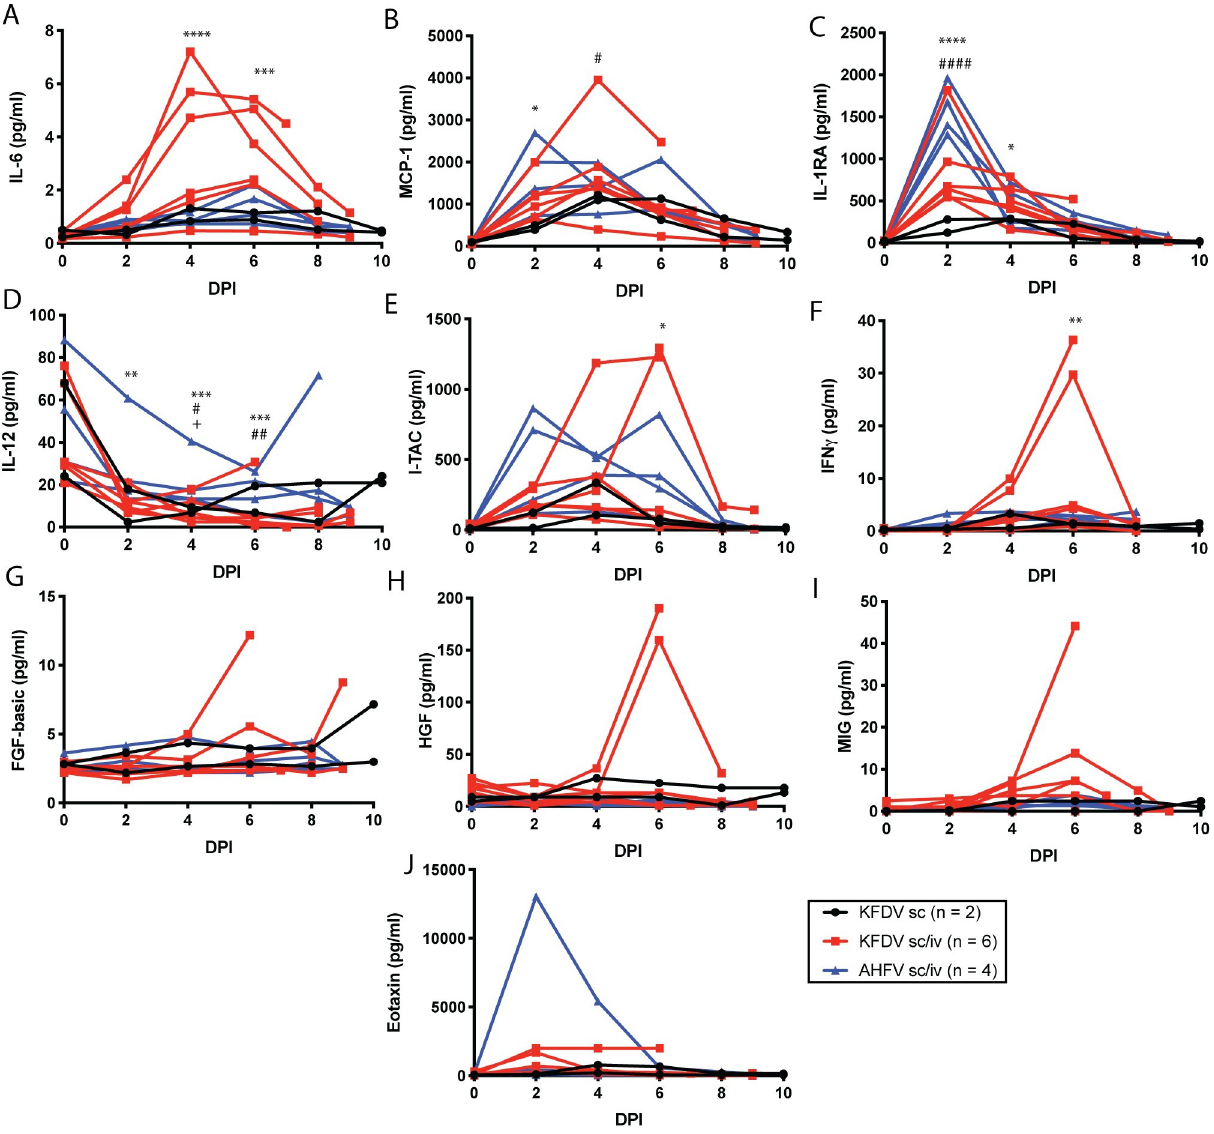
Fig 3. Cytokine and chemokine analysis in serum of KFDV and AHFV-infected animals. Pigtailed macaques were infected with KFDV by the sc or sc/iv route, or AHFV by the sc/iv route. The number of animals in each group is indicated in the legend. Serum was isolated from blood samples obtained during clinical exams at the indicated days post infection. Cytokine and chemokines were measured from sera using a 29-plex Monkey cytokine detection kit. The following parameters are included: A. IL-6, B. MCP-1, C. IL-1RA, D. IL-12, E. I-TAC, F. IFN γ , G. FGF-Basic, H. HGF, I. MIG, J . Eotaxin. Statistics were performed by comparing the change in the parameter compared to the D0 measurement using Sidaks multiple comparison test. Significance symbols are represented as follows: KFDV sc/iv � , AHFV sc/iv #, KFDV sc +. (KFDV sc/iv N = 6, AHFV sc/iv N = 4, KFDV sc N = 2; � P < 0.05, �� P < 0.005, ��� P < 0.0005, ���� P < 0.0001.